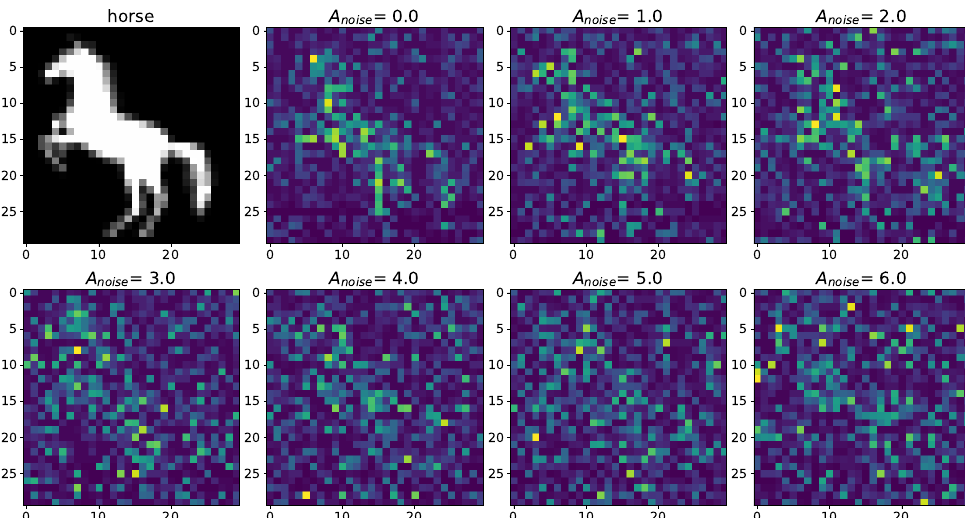
Figure 5. Changes in the spatial sweep of the spiking neural network during the representation of the supplied image from the Figure 2 when the amplitude, A noise , of the noise current, I noise , changes from 0 to 6 without modulation of neuronal activity by astrocytes.